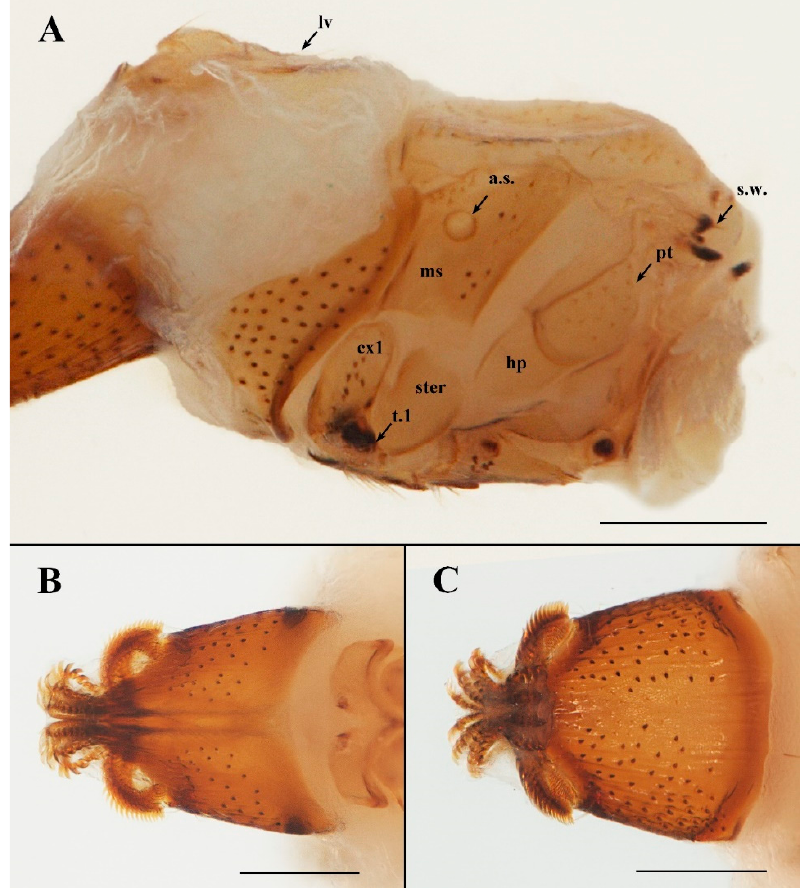
Figure 3. Ascodipteron guoliangi sp. nov., ex. Coelops. frithii , China (BFU-2437, neosome paratype). ( A ). Thorax, lateral view. ( B ). Labial theca, dorsal view. ( C ). Labial theca, ventral view. Abbreviations: a.s.—anterior thoracic spiracle; cx1—coxa 1; g—gena; hp—hypopleuron; lv—lateral vertex; ms— mesopleuron; pt—pteropleuron; s.w.—stump of wing; ster—sternopleuron; t.1—trochanter 1. Scale bars: A – C = 200 µ